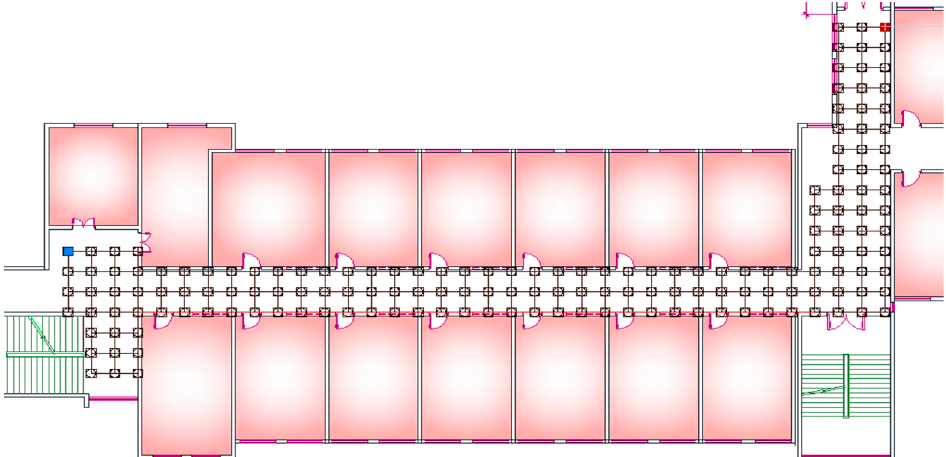
Figure 7. The distribution of test points and reference points: the red point is the starting point and the blue is the end.